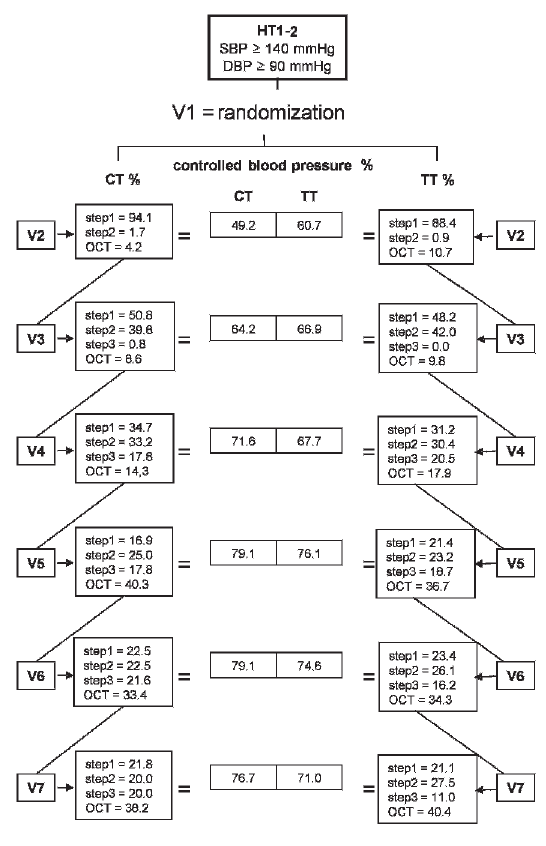
Figure 2 - The percentage of patients with grade 1 or 2 hypertension (HT1-2) at each scheduled medical visit that reached the therapeutic target blood pressure and remained in the original protocol until the end of the study. The patients are divided according to their treatment